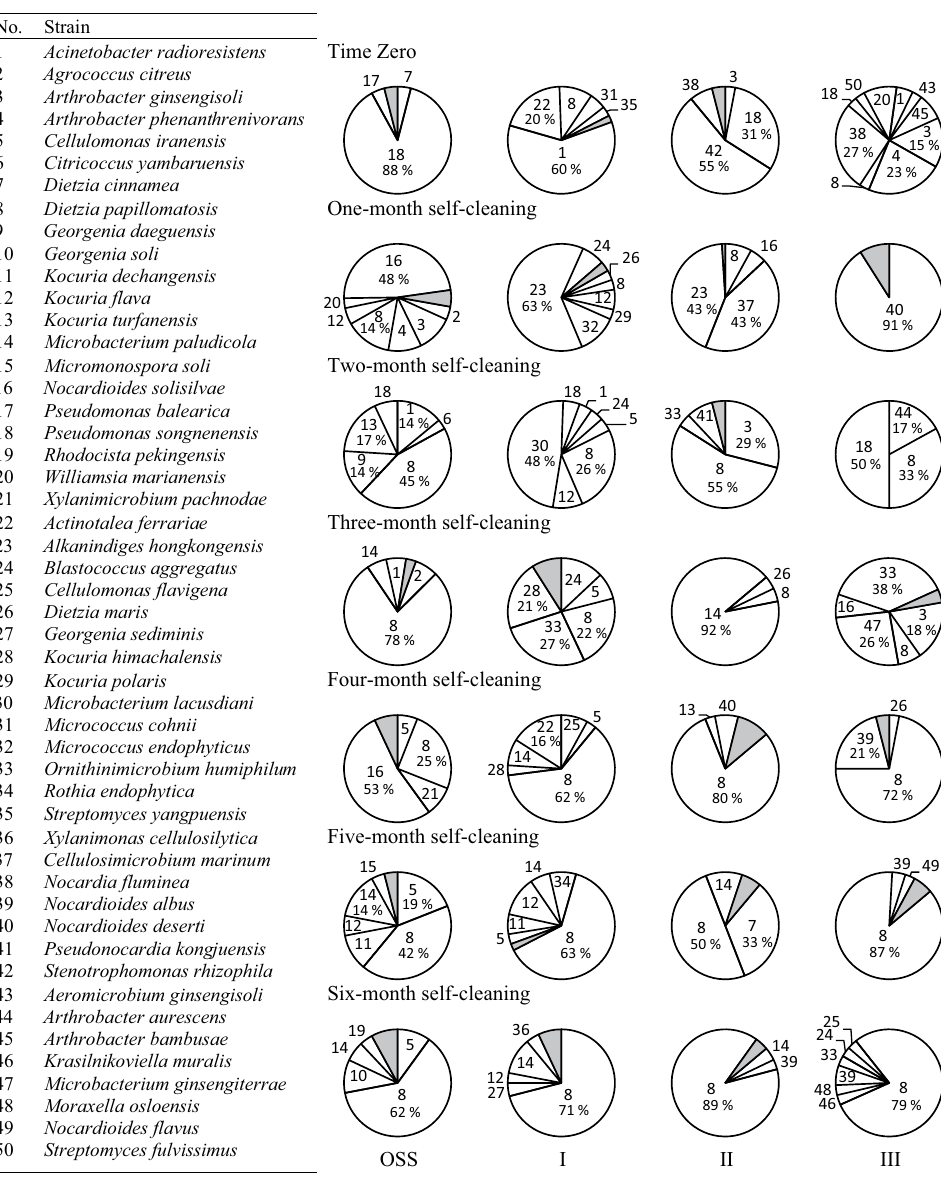
Figure 2. Dynamics of hydrocarbonoclastic microbial communities in the oil-saturated soil (OSS) and OSS diluted (with pristine garden soil: I, 1 kg OSS + 0.25 kg; II, 1 kg OSS + 0.5 kg; III, 1 kg OSS + 0.75 kg) during bioremediation. Shaded areas contain all the bacterial strains with ≤ 2% occurrence. For minor organisms in the shaded areas, refer to Supplementary Table